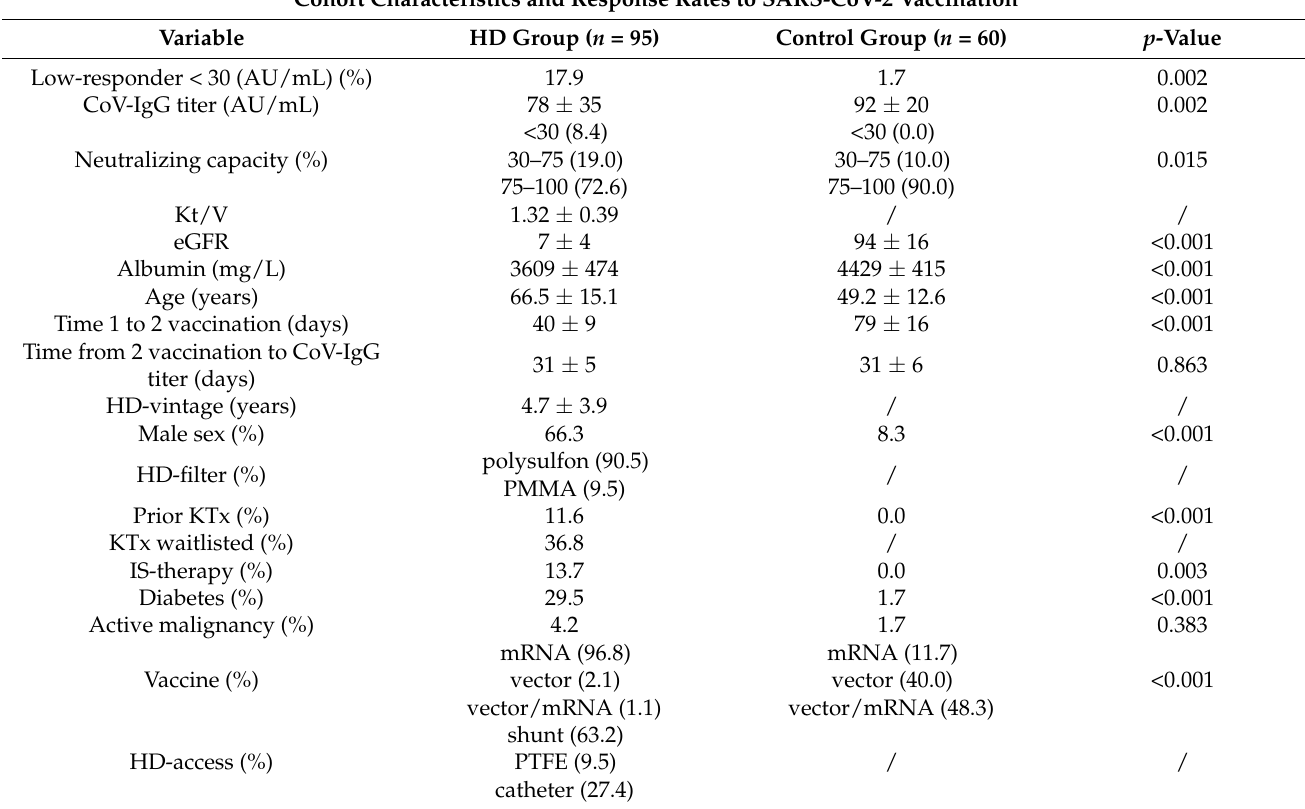
Table 1. Basic cohort characteristics. HD = hemodialysis, Kt/V = measured by online-conductivity measurement de- vice OCM™ Fa. Fresenius Medical Care, KTx = kidney transplantation, PMMA = polymethylmetacrylate membrane, IS = immunosuppressive, eGFR = CKD-EPI formula in mL/min/1.73 m 2 BSA. Continuous variables are shown as mean ± standard deviation, categorical variables are shown in numbers and percent. Statistical analyses were performed by t-test for unpaired variables for continuous data and Chi-square test for categorical variables. Cohort Characteristics and Response Rates to SARS-CoV-2